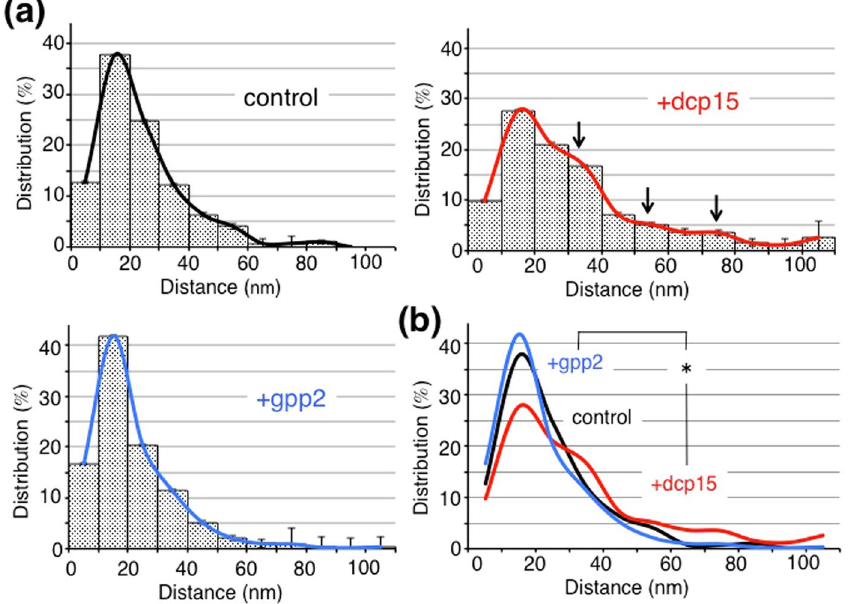
Figure 3. Distributions of lengths between intersections. Histograms of lengths between intersections were plotted (control, + dcp15, + gpp2), and averaged data were also fitted (mean ± SEM, n = 4). The histogram for dicalcin-derived peptide-treated VE exhibited bumps at windows of 30–40, 50–60, and 70–80 nm (arrows). Fitted curves were overlaid (Black, Red and Blue for control, dcp15 and gpp2,